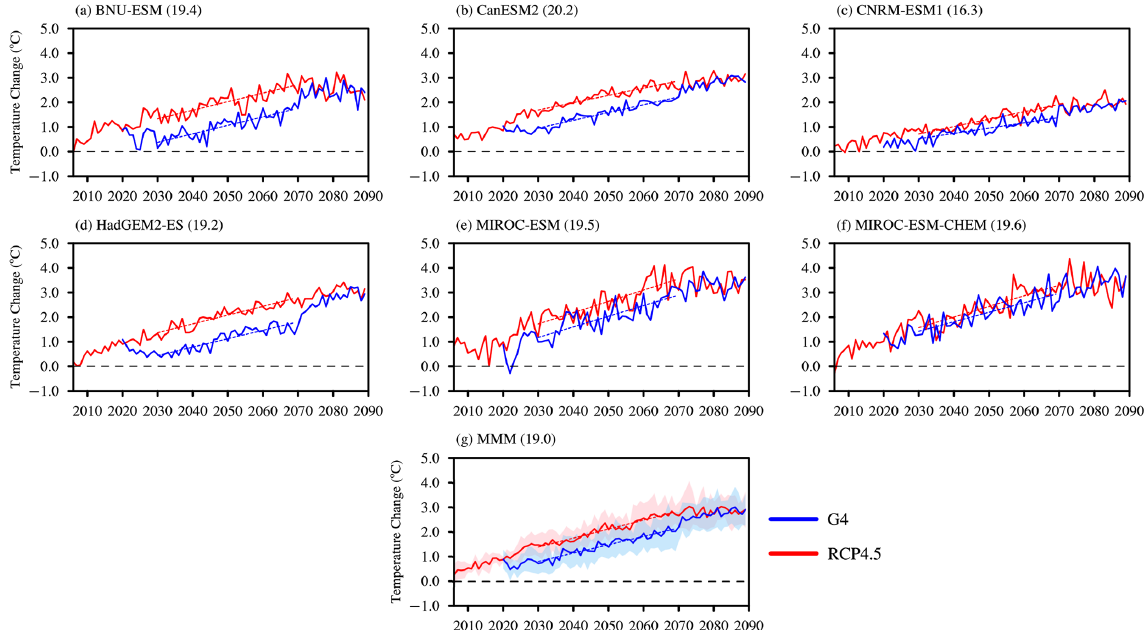
Figure 4. Time series of regionally averaged surface air temperature (units in ◦ C) over China in the G4 experiment (solid blue lines) and RCP4.5 scenario (solid red lines) in summer. The values are obtained by subtracting the present climatology (mean of 1986–2005; represented in parentheses) in the historical experiment. Blue and red dashed lines represent the linear trends of G4 and RCP4.5 simulations during the period of 2030–2069, respectively. The multi-model mean (MMM) is represented at the bottom, with the shading indicating 1 inter-model standard